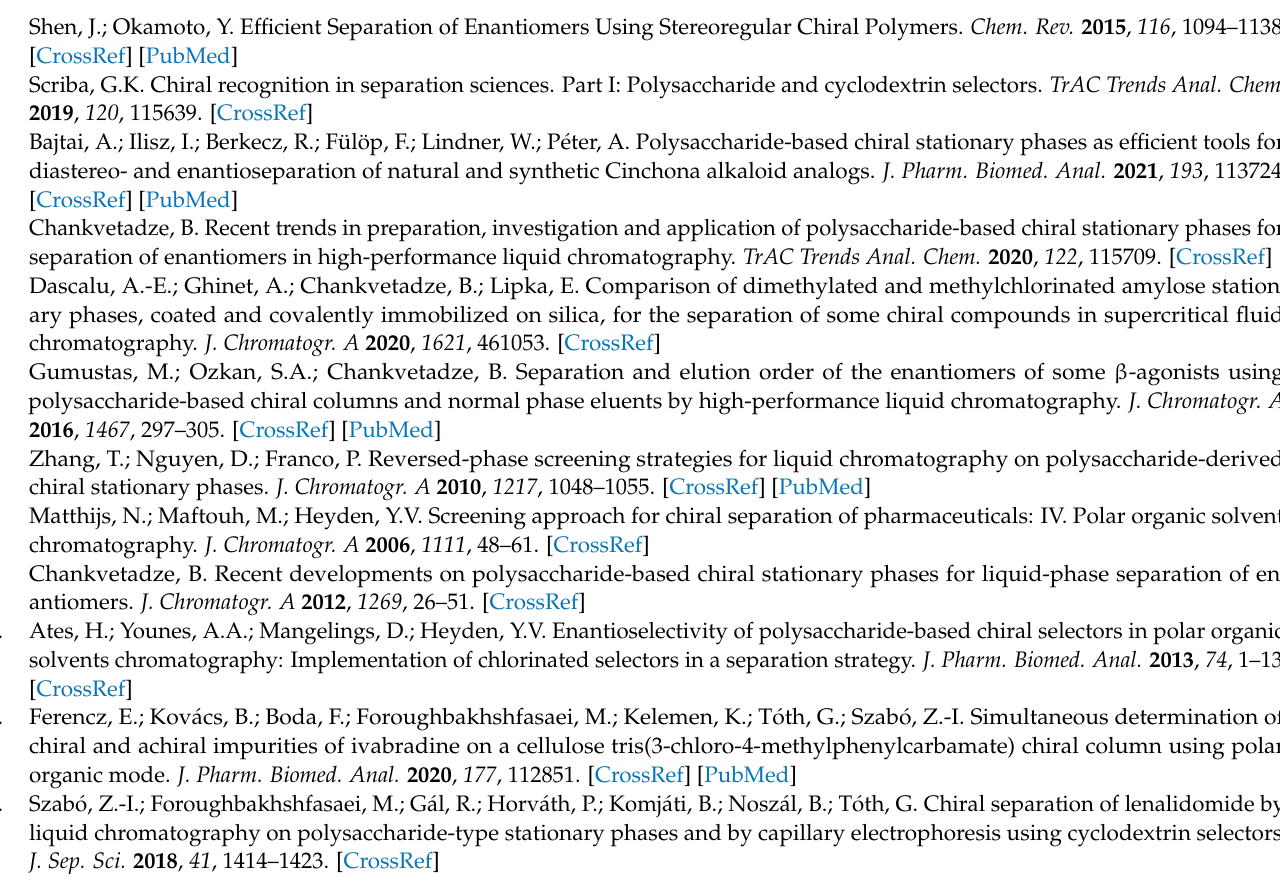
Figure S8: POM on Chiralcel OD column using 100% MeOH (A), 50/50 MeOH/IPA mixtures (B), 100% IPA (C) as eluent. The Rs values are 3.40, 4.87 and 2.33, respectively, Figure S9: Representative graphs of retention factor/separation factor vs. eluent composition (A): Retention factor of R-POM in different MeOH/IPA compositions on Lux Amylose-2 column, (B): Separation factor of POM enantiomers in different MeOH/IPA compositions on Lux Amylose-2